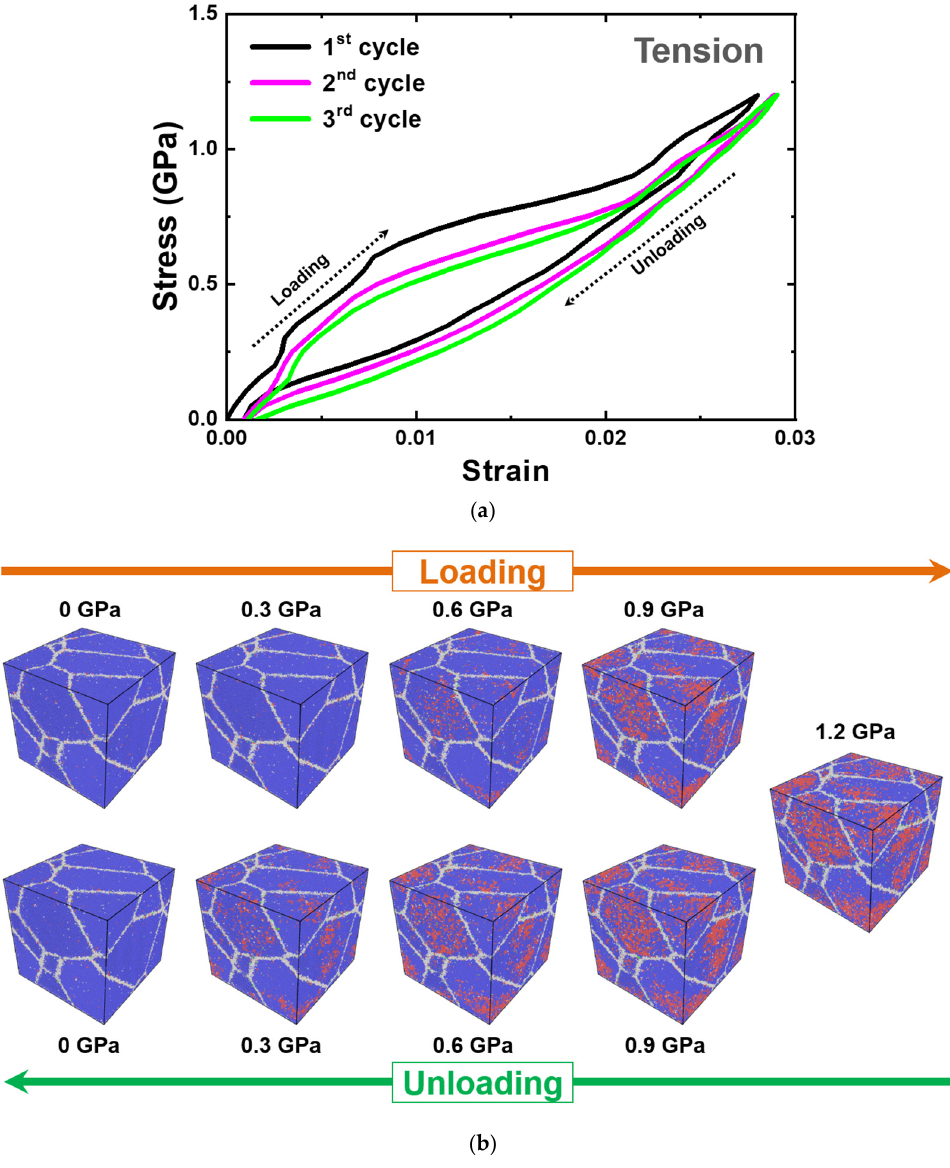
Figure 10. ( a ) Tensile stress–strain curve of the nanocrystalline equiatomic PtTi with 5 grains simu- lated at 1300 K. ( b ) The corresponding atomic configurations of the third cycle colored according to the PTM method [95] at regular intervals. The blue atoms correspond to the B2 austenite structure, red atoms to the B19 martensite structure, green atoms to the twin boundaries, and gray atoms to the domain or grain boundaries.